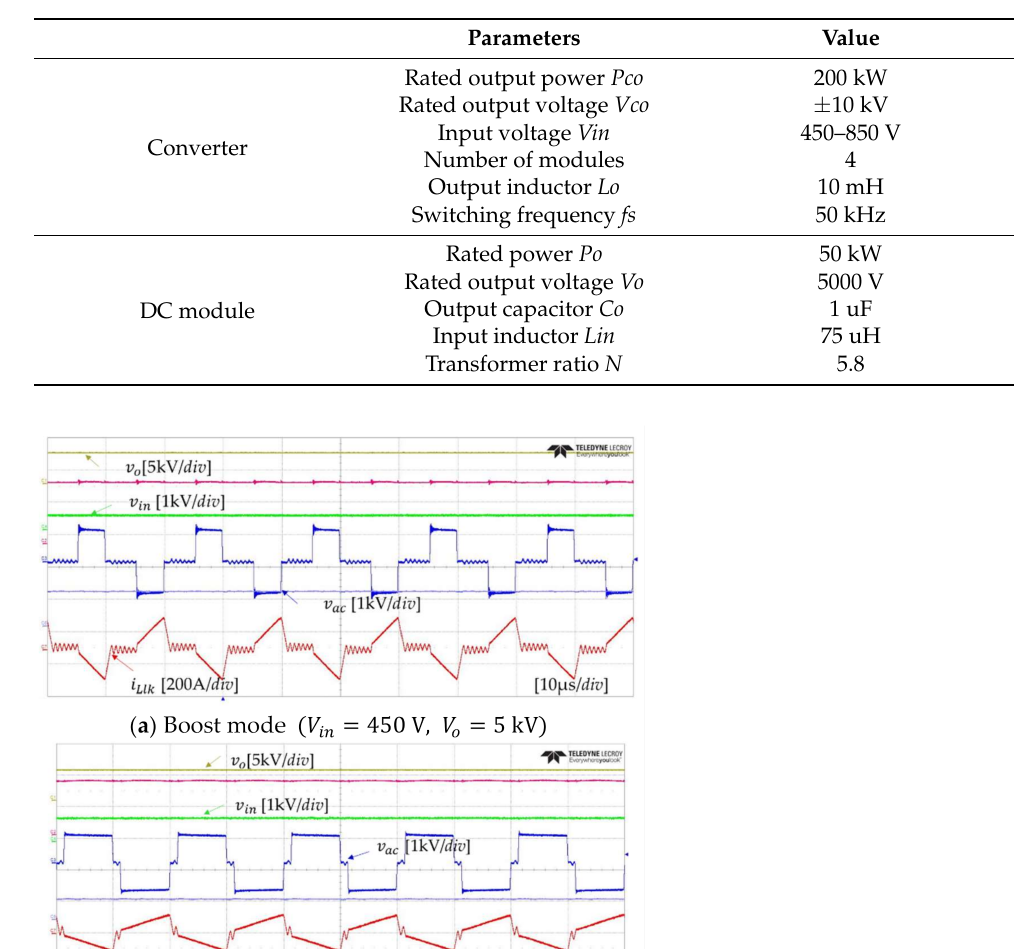
Table 3. Parameters of converter and dc module.